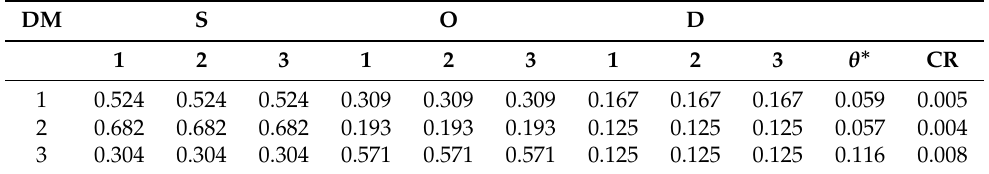
Table 5. The optimal weights of triple